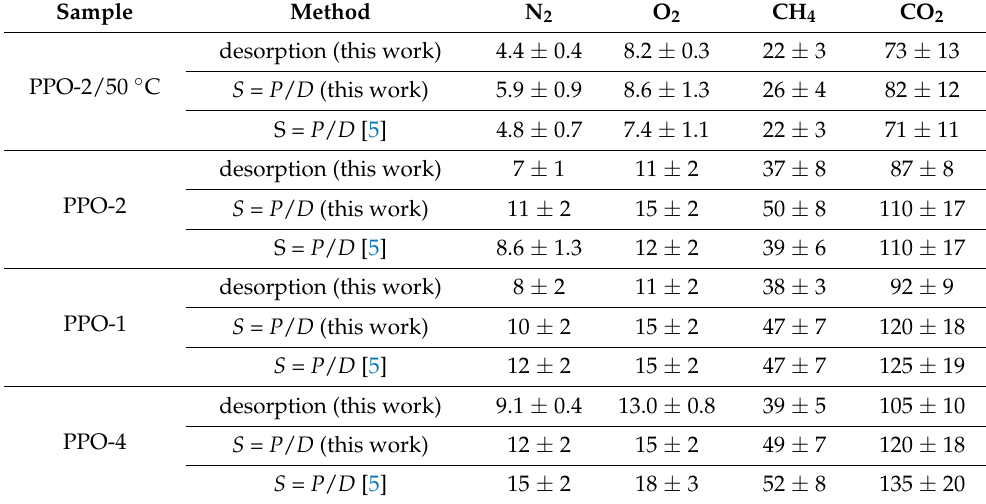
Table 8. Comparison of gas solubility coefficients ( S · 10 3 , cm 3 (STP)/(cm 3 · cmHg)) obtained at 35 ◦ C by a volumetric method with chromatographic detection (desorption is highlighted in bold) and calculated as S = P / D in present paper and in [5] for PPO-2/50 ◦ C, PPO-1, PPO-2, and PPO-4 film samples. The series of gases is given in the order of increasing T c (Table 7); the series of PPO samples is given in the order of increasing the degree of crystallinity and free volume (Table 7). Sample